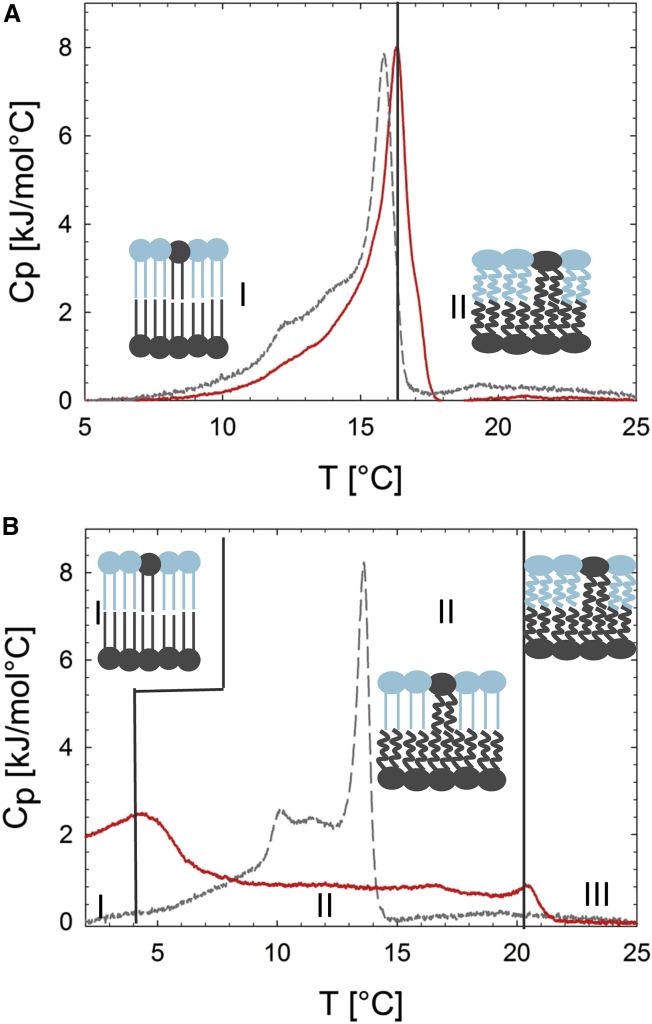
DSC cooling scans of POPCout/POPEin (A) and POPEout/POPCin (B) aLUVs (D/A = 3) (solid lines). Transitions of the corresponding scrambled LUVs are shown as gray dashed lines. (Insets) Schematics of leaflet structure. See Fig. S7 for the corresponding D/A = 2 data. To see this figure in color, go online.